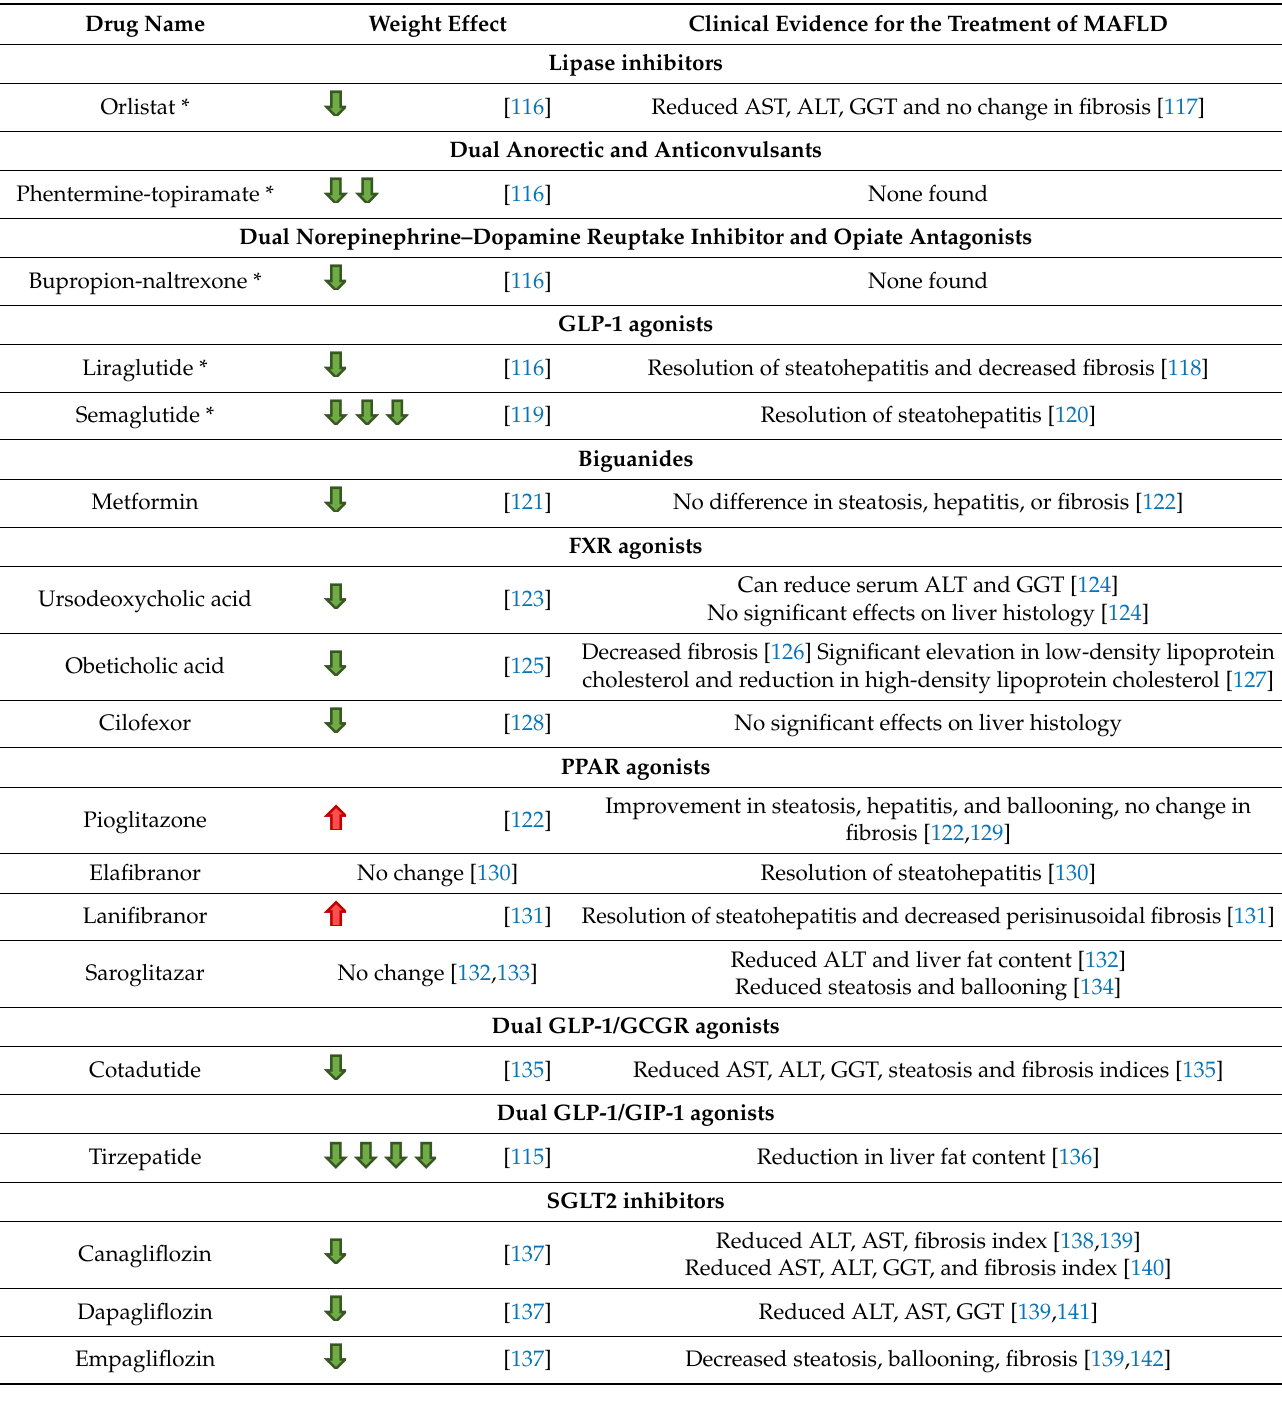
Table 1. Pharmacological Approaches to the Treatment of Obesity-related